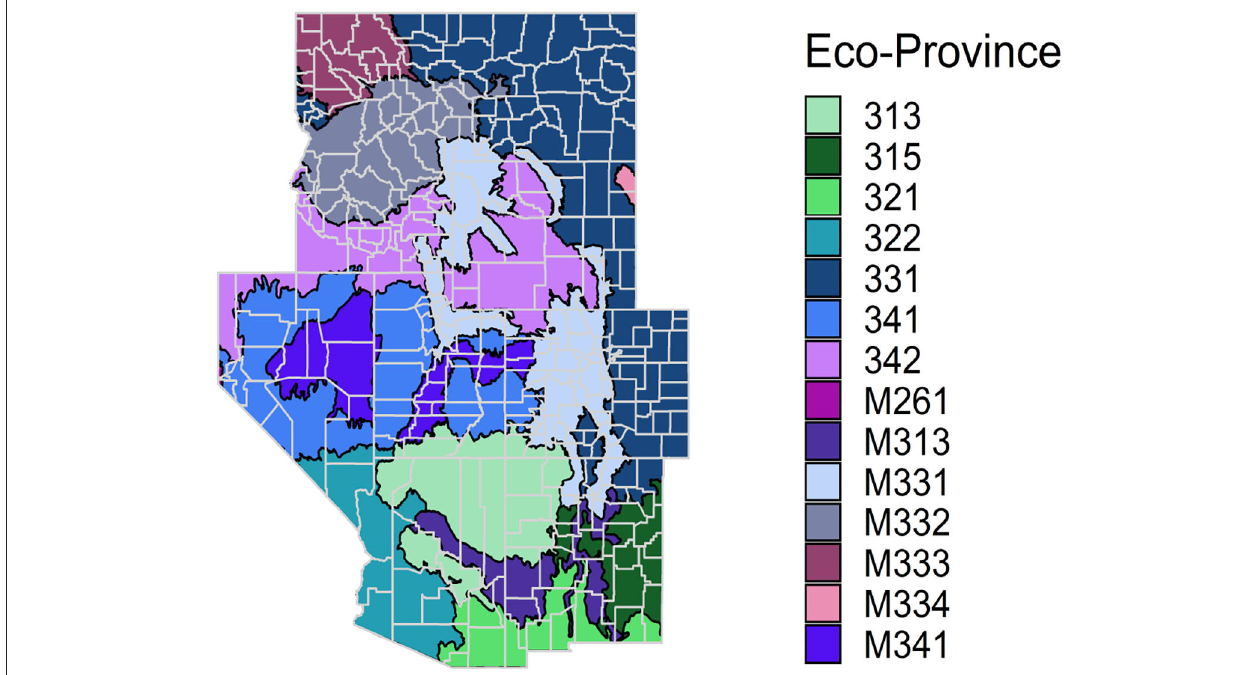
FIGURE 1 | A map of counties in the Interior West, colored by